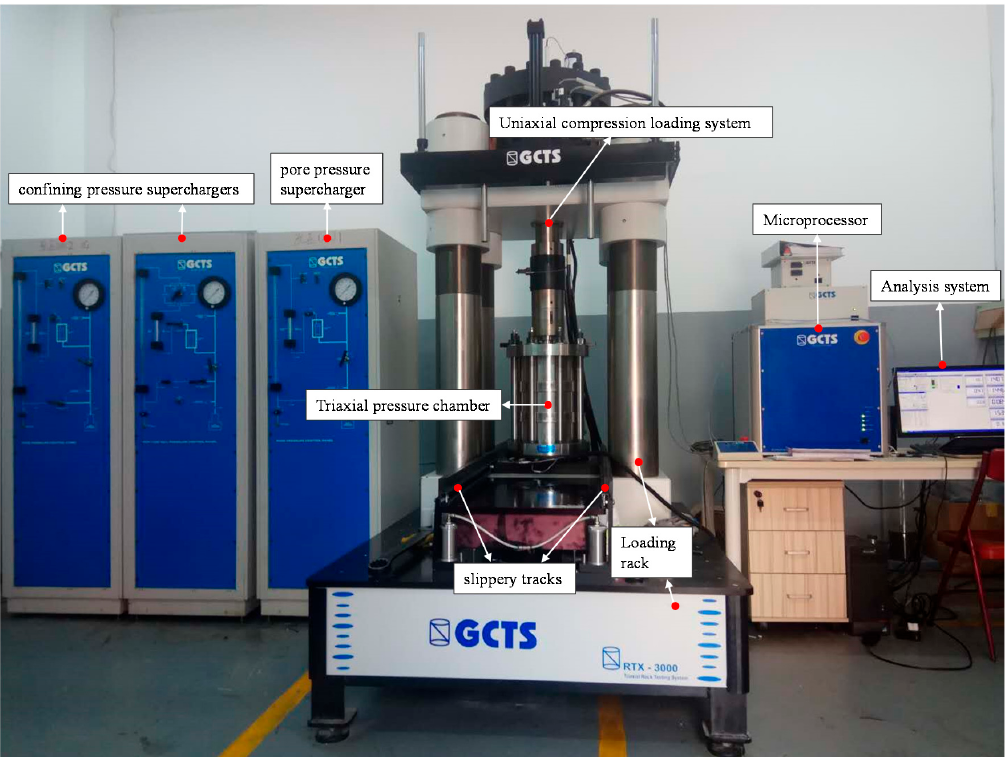
Figure 2. GCTS RTX-3000 triaxial rock testing system.